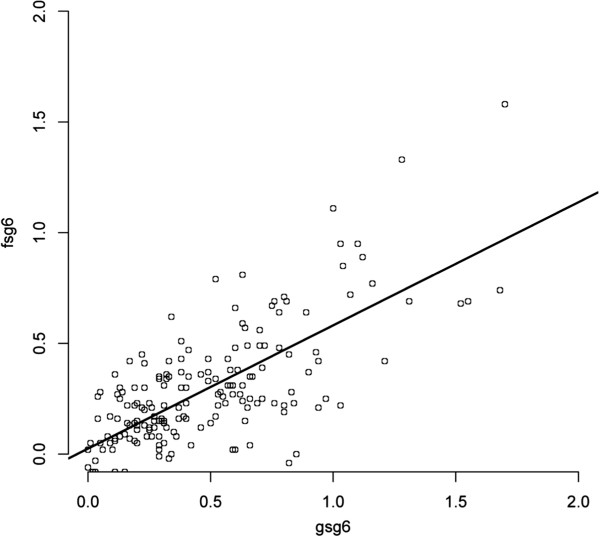
Correlation of IgG responses between SG6 ortholog recombinant proteins from two distinct Anopheles species. A scatter plot analysis of IgG response to gSG6 is presented, and the aOD values among the 134 exposed individual are reported. For gSG6 and fSG6 measurements, the best-fit is shown as a black line (slope 0.5923±0.0527), with a Spearman’s rank correlation coefficient (rho) of r = 0.6208, p <0.0001.